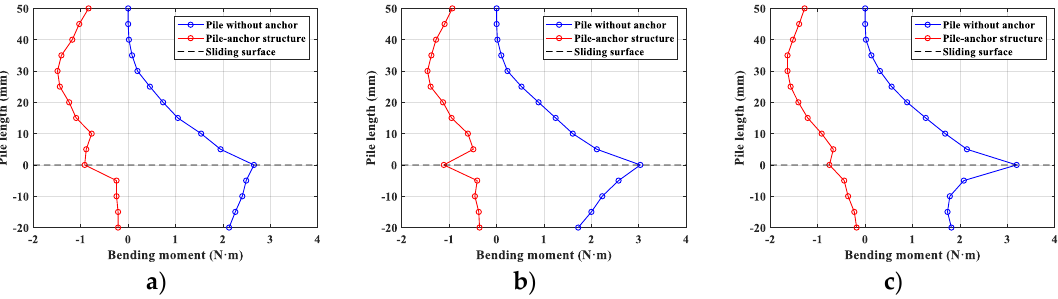
Figure 10. Bending moment distribution of the pile. ( a ) No.1 (embed depth 75 mm), ( b ) No.2 (embed depth 50 mm), ( c ) No.3 (embed depth 25